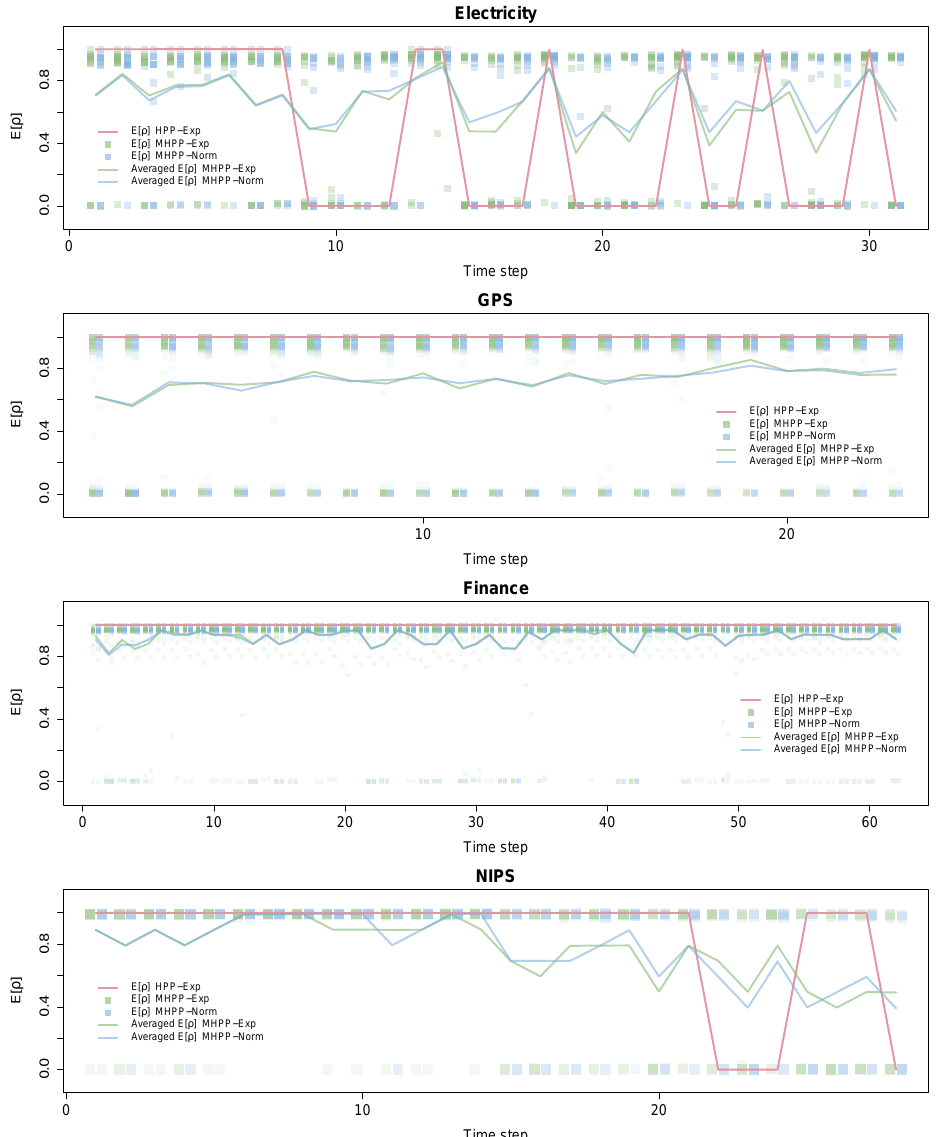
Figure 8. Evolution of E q [ ρ t ] for SVB-HPP and SVB- multiple hierarchical power prior